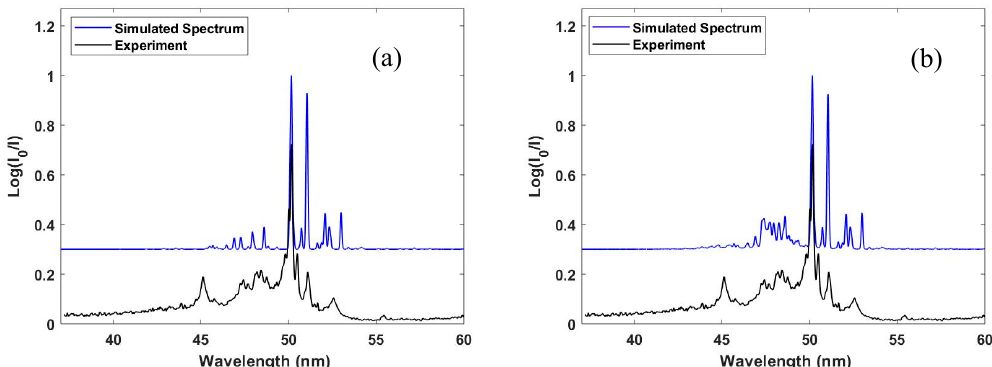
Figure 3. A comparison between the synthetic spectra and experimental data. ( a ) Simulated spectrum including photoabsorption from the ground electron configuration of Bi + only. ( b ) Simulated spectrum including photoabsorption both from the ground and from low-lying excited states of Bi + .